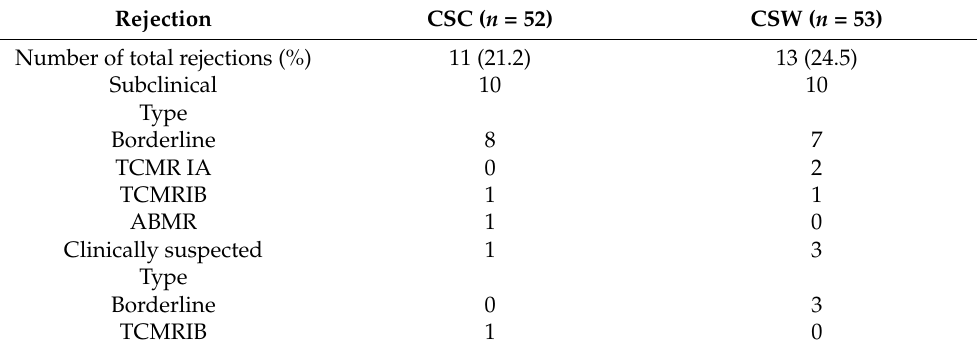
Table 3. Rejection episodes occurring after